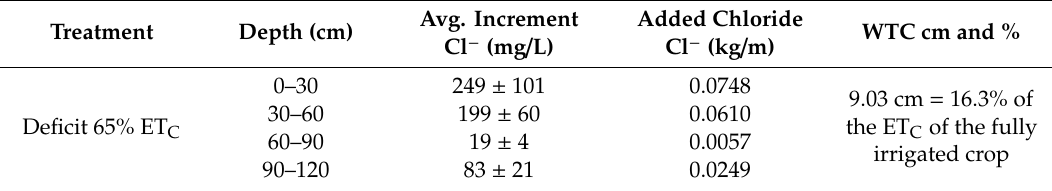
Table 6. Water table contribution (WTC) to sunflower water use for each soil layer (cm) for the deficit irrigation (65% ET C ) treatment where salinity for the applied irrigation water, EC a = 1.13 dS · m − 1 and chloride Cl − = 98 mg · L − 1 .